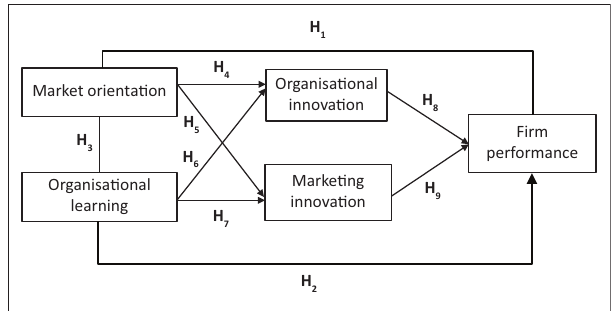
FIGURE 1: Research